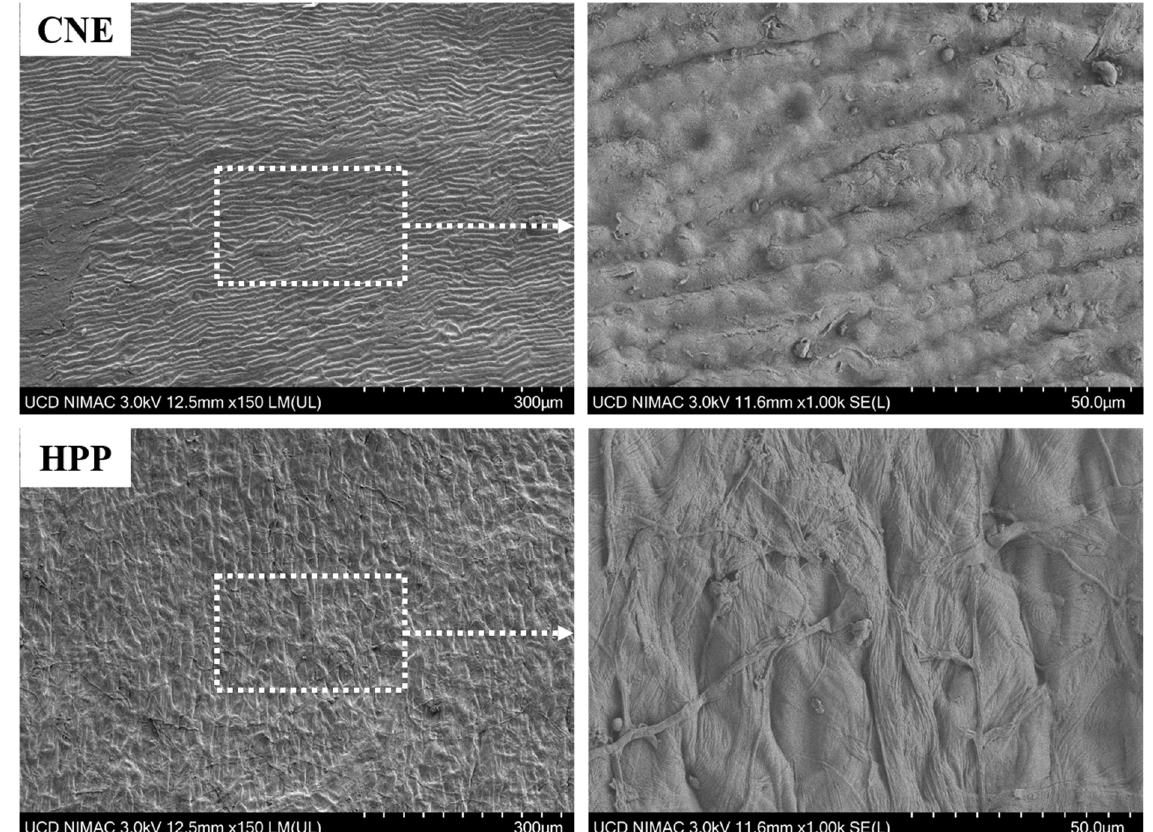
Figure 6. Scanning electron micrographs of the surface structure of Buckwheat hull before and after novel extraction at magnifications—300 μ m and 50 μ m.